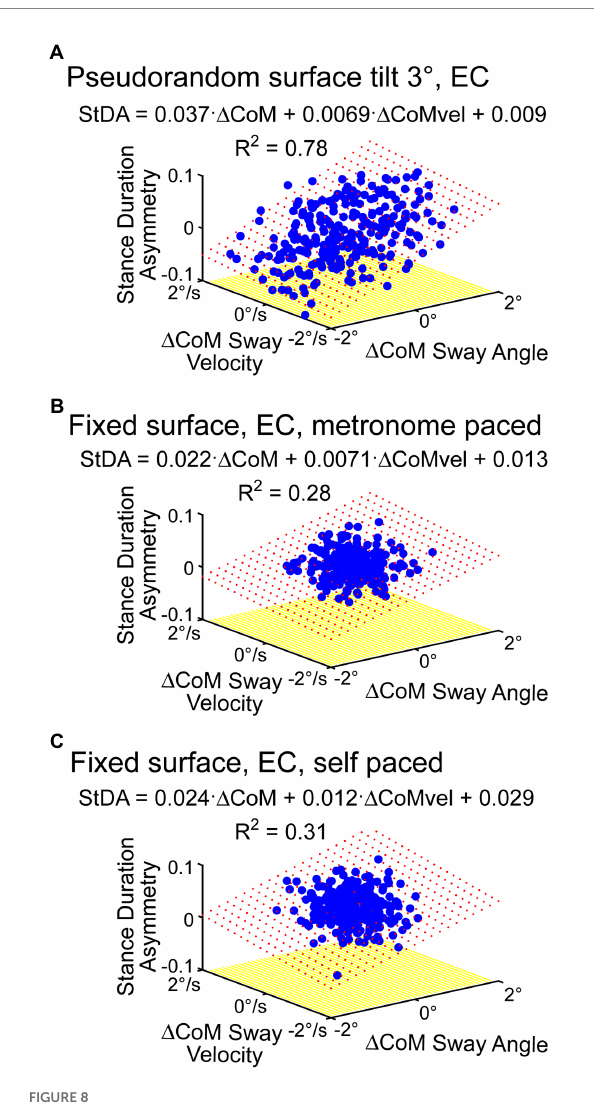
FIGURE 8 Examples of regression analysis applied to metronome-paced (A,B) and non-metronome-paced trials (C) using time series of individual asymmetry measures. (A) Shows regression analysis results of StDA using data from the same subject and trial as shown in Figure 7. (B) Shows StDA regression analysis results from a metronome-paced eyes-closed stepping-in-place trial performed on a fixed, unmoving surface. (C) Shows results from the same subject and same conditions as in (B) except with self-pacing rather than metronome pacing. Red dotted surface represents the regression